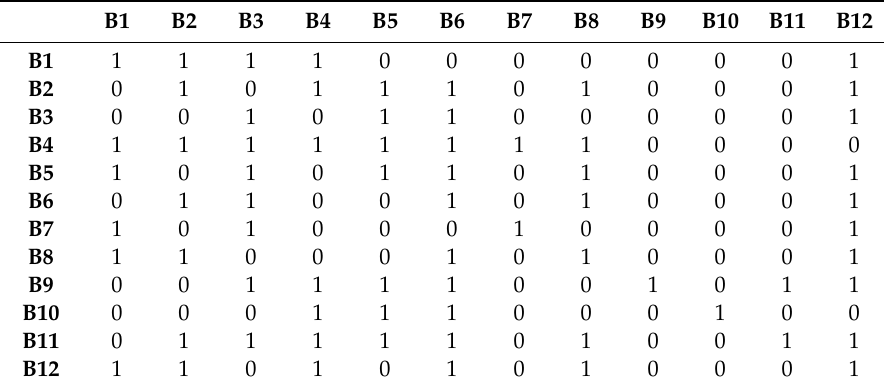
Table 9. Initial Reachability